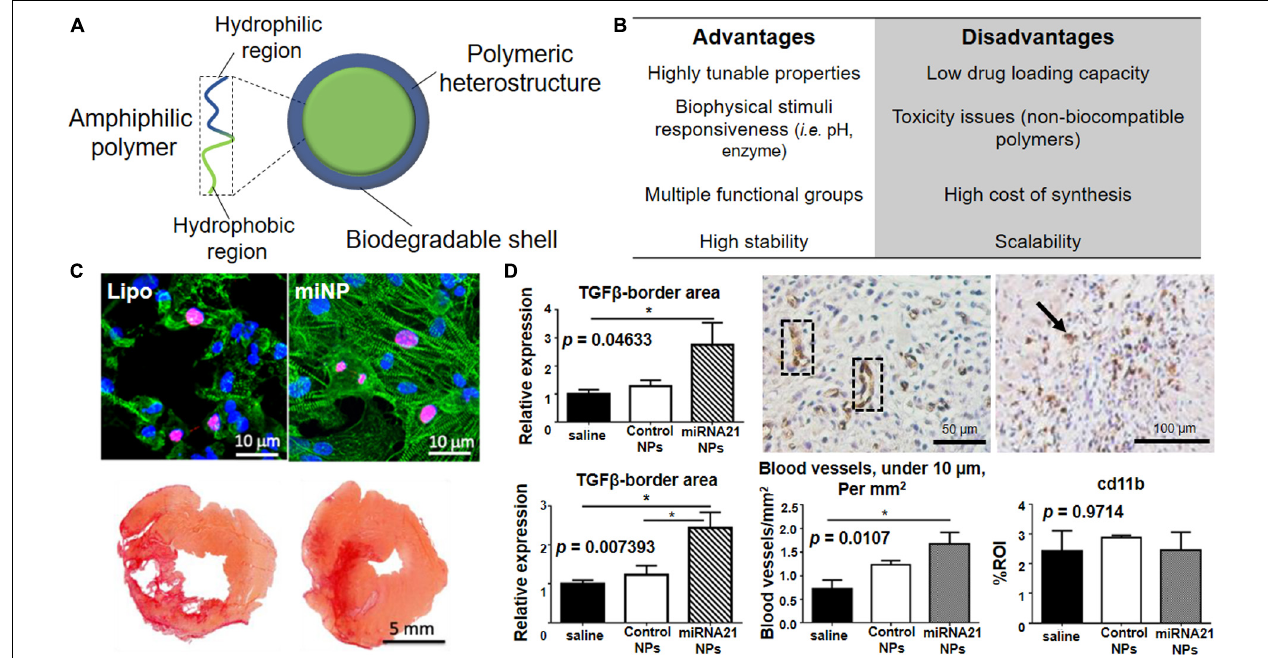
FIGURE 5 | Polymeric NPs for cardiac repair. (A) Schematic representation of polymeric NPs with overall composition and structure. The use of amphiphilic building block allows the formation of micelle-like structures in aqueous media. (B) Advantages and disadvantages associated with the use of polymeric nanoparticles in term of synthesis, long-term stability and clinical translation of the material. (C) Top. Polymeric nanoparticles carrying miRNAs (miNPs) are significantly less toxic for human embryonic stem cell-derived cardiomyocytes when compared to lipofectamine (lipo). Alpha-actinin (green) stains the contractile structure and Ki67 (red) accounts for the proliferation capacity. Nuclei are counterstained by DAPI (blue). Bottom. Picro Sirius Red ex vivo staining of heart transversal tissue sections showing a clear reduction of the scar size and fibrosis in left ventricle for the heart treated with miNPs (right) in comparison to the same particles carrying a scramble miRNA (left). (D) Left. miRNA-21 NPs myocardial infarction treatment causes increased levels of anti-inflammatory cytokine TGF- β both at infarction border zone (top) and in remote myocardium (bottom) when compared to saline-treated or control. Center. miRNA-21 NPs induce neovascularization in infarcted mouse myocardium, as shown by CD31 + blood vessels in cross-sections of the heart (dotted black box) and quantified in the graph by comparing it with saline and control NPs-treated groups * p < 0.05. Right . Histological analysis shows the presence of macrophages in infarcted heart treated with miRNA-21 NPs, as shown by CD11b-positive cells positive cells (black arrow), but no macrophage accumulation as compared to saline and control NPs as shown in the graph. Reprinted from: (C) (Yang et al., 2019) with permission from American Chemical Society; (D) (Bejerano et al., 2018) with permission from American Chemical